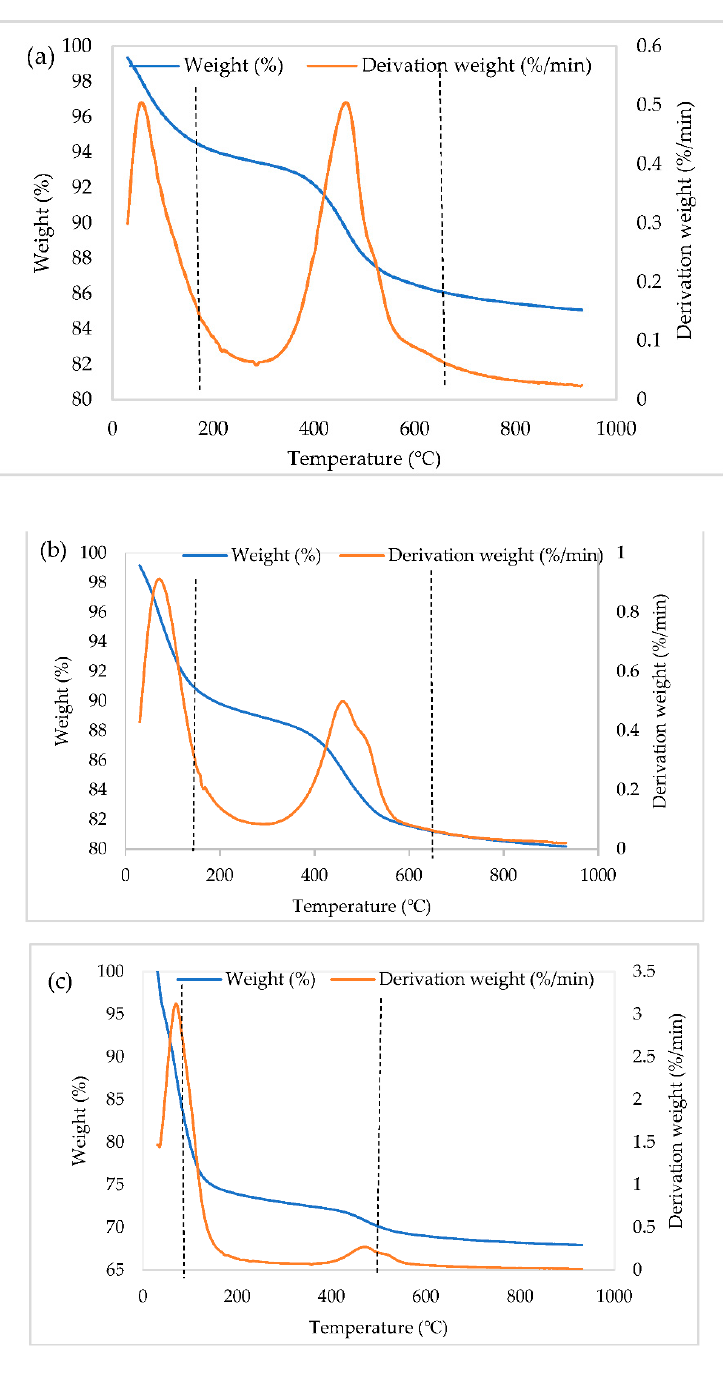
Figure 10. TGA-DTA spectra of the ( a ) support (Al 2 O 3 ), ( b ) adsorbed metal oxide (MgO-Al 2 O 3 ) species taken after heating at 300 ◦ C, and ( c ) CRL immobilized on the support (CRL/MgO-Al 2 O 3